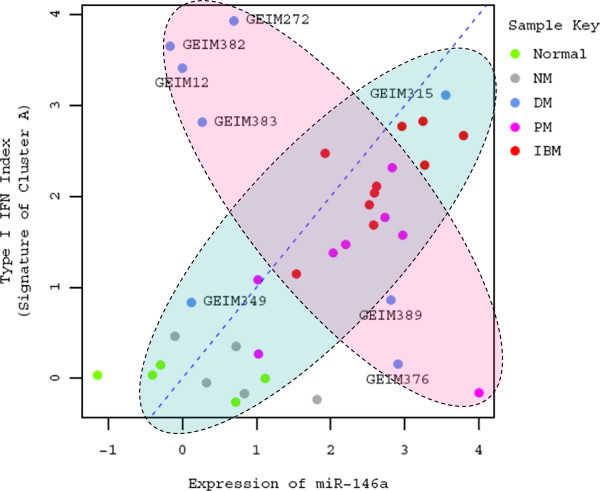
Intricate association between the expression of miR-146a and type 1 IFN signature score in a subclass of myositis. Data points are colored by the sample type in this scatter plot; color key is displayed in the upper right corner of the plot. The identity reference line y=x is denoted by the blue dotted line. Type 1 IFN signature displays a positive pattern of association in most subjects including the normal control, NM, PM, IBM and some DM, as highlighted in the light blue shaded oval. On the other hand, the type 1 IFN signature displays a negative pattern of association with the expression level of miR-146a in most DM (highlighted in the pink shaded oval). The subject identifiers of the eight DM subjects are all labeled in this plot.